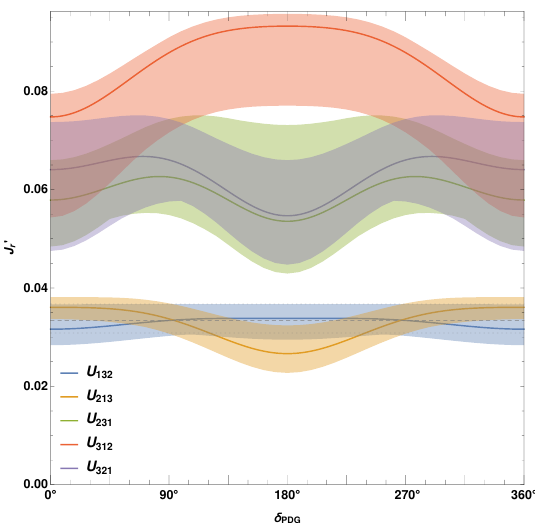
for each parameterization as a function of δ ≡ J r sin( δ 0 ) for U using the best fit mixing angles from [60] and the r PDG for U when allowing the mixing angles r PDG